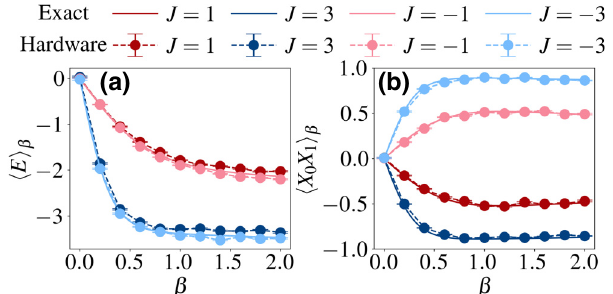
FIG. 6. (a) Finite-temperature energy (cid:9) E (cid:7) β and (b) static cor- relation function (cid:9) X 0 X 1 (cid:7) β of the two-site TFIM with J = ± 1, ± 3 and h = 1 versus inverse temperature β . The imaginary-time- step size in QITE is (cid:3)τ = 0.1. The observables obtained on hardware are within 1–4% of the exact